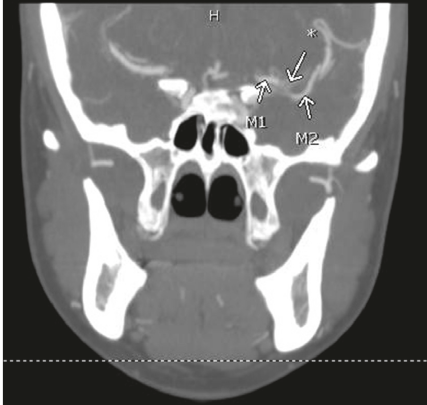
Figure 3: CTA neck showing a short segment of partially recanalized vessel ( ∗ ) between M1 and M2 segments of left